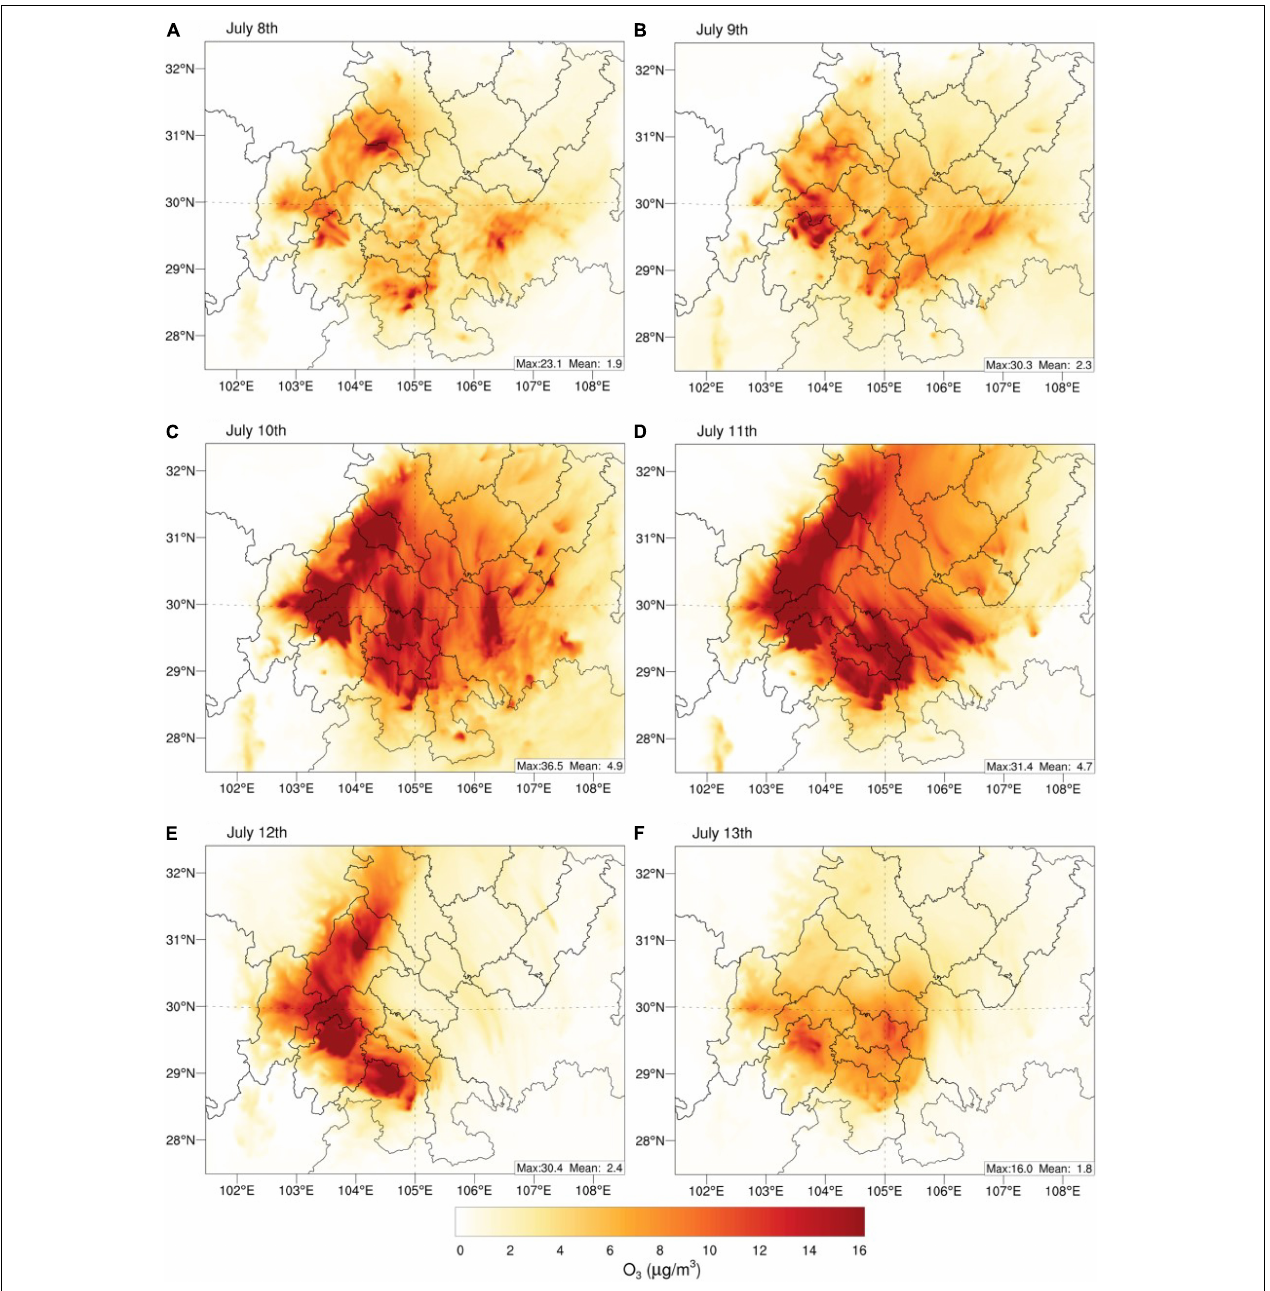
FIGURE 8 | Impacts of BVOC emissions on MDA8 O 3 concentrations (i.e., baseline minus nobio) simulated by CMAQ model over SCB during 8–13 July in